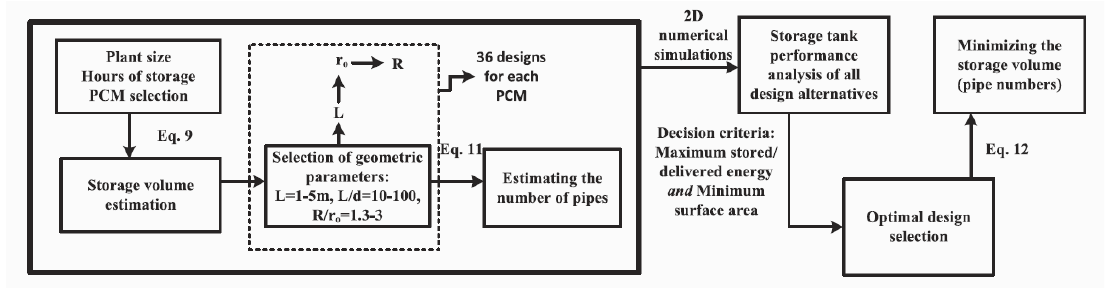
Figure 1. The design process of the PCM ‐ HEX unit for solar tower power plants [24].